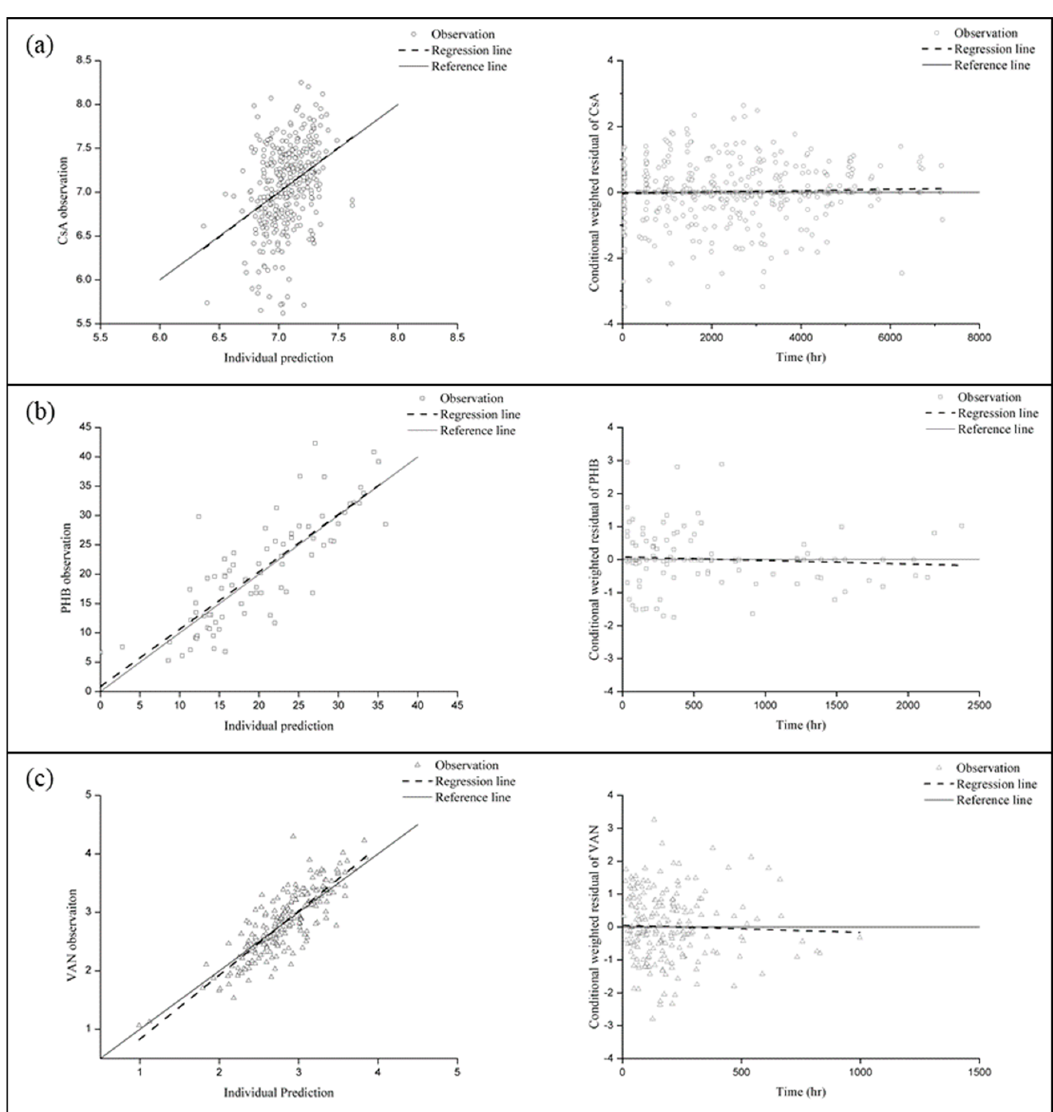
Figure 2. Goodness of fit plots of the final models. ( a ) Cyclosporine A (CsA), ( b ) phenobarbital (PHB), ( c ) vancomycin (VAN), open circle: CsA observation, open square: PHB observation, open triangle: VAN observation, solid line: reference line (y = x line for IPRED versus observation plot, y = 0 for CWRES versus time plot), dashed line: regression line.